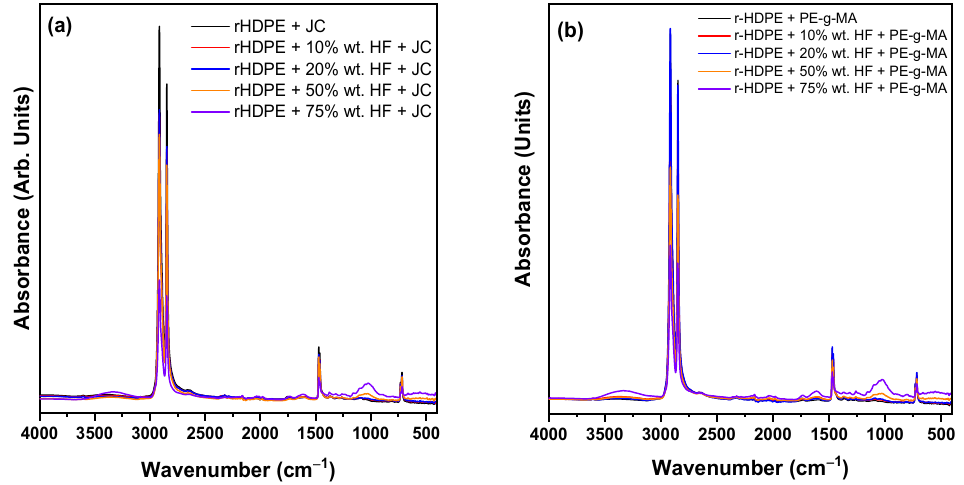
Figure 3. ATR spectra of the prepared ( a ) recycled high-density polyethylene (r-HDPE) + hemp fibers (HF) + Joncryl (JC), and ( b ) r-HDPE + HF + polyethylene-grafted maleic anhydride (PE-g-MA) composite materials.